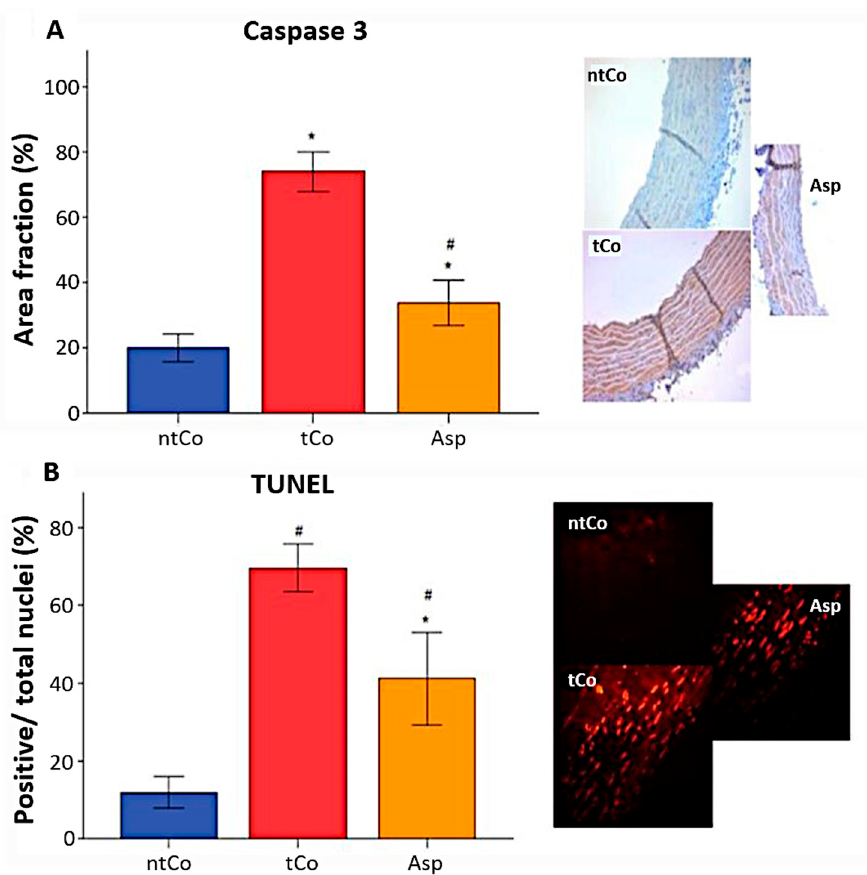
Figure 4. Antiapoptotic effect of the Aspirin pretreatment was found based on ( A ) the significantly increased Caspase-3 immunoreactivity and ( B ) the significantly increased TUNEL positivity. * p < 0.05 vs. ntCo, # p < 0.05 vs. tCo. Magnification: 200×.